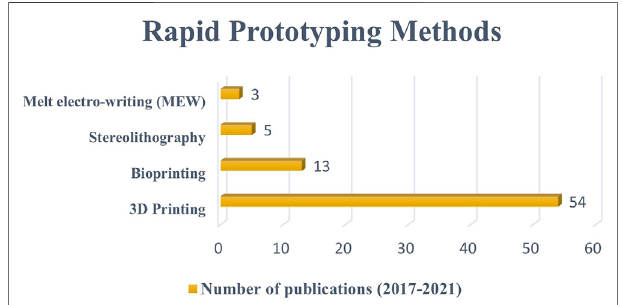
FIGURE 4 | The number of publications on the use of rapid prototyping methods to fabricate conductive sscaffolds between 2017 to 2021 ( fi ve-year period). Data as of 1st September 2021 from Web of Science.